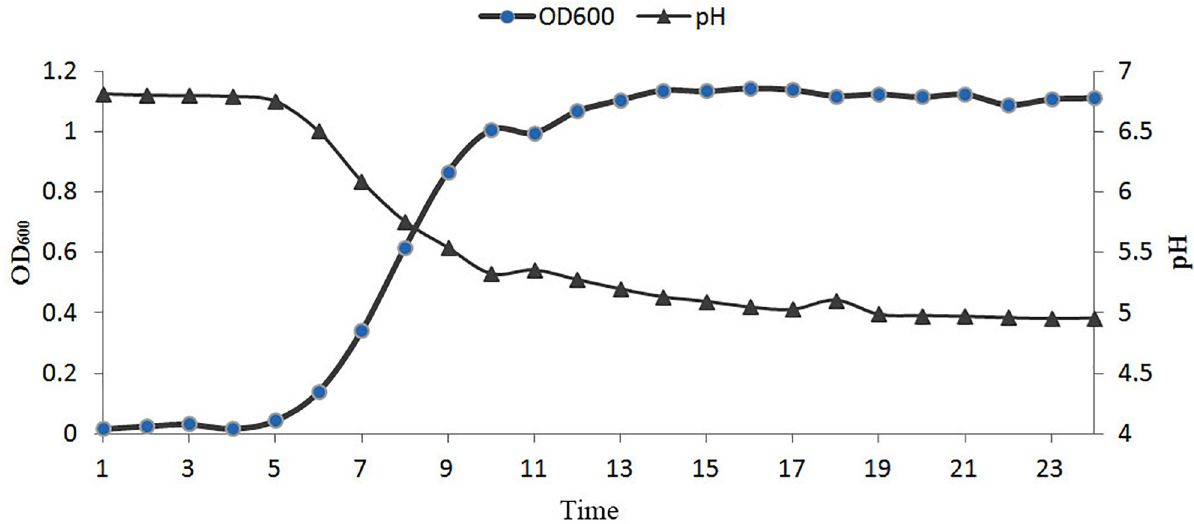
Fig 5. Growth and pH curve of C . sartagoforme XN-T4 .